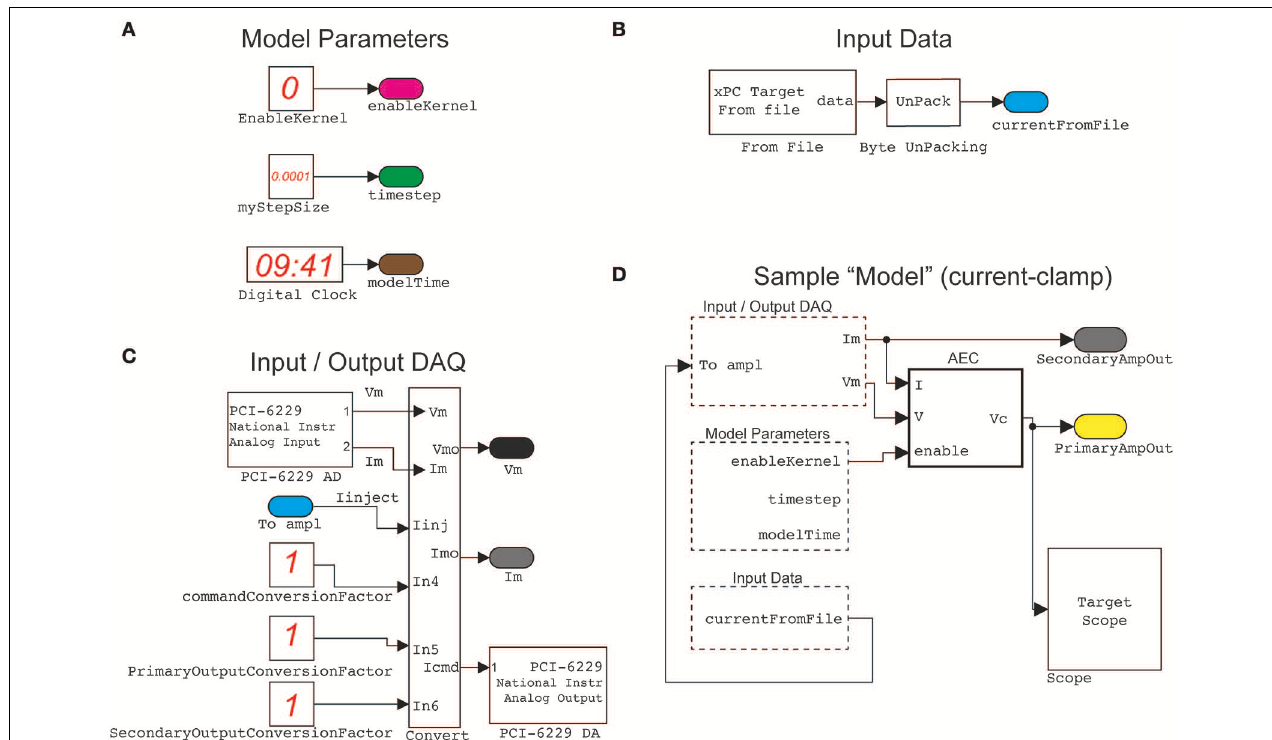
FIGURE 2 | A sample of elementary building blocks and their visual configuration. Basic parameters, such as the sampling interval and a switch enabling the operation of the Active Electrode Compensation (as a stand-alone block) are encapsulated (A) in a block named ModelParameters. Another block, named InputData (B) provides an interface to arbitrary stimulation waveforms (e.g., time-varying current commands, voltage commands, conductance commands, etc.), generated off-line by the host PC, and connected to the